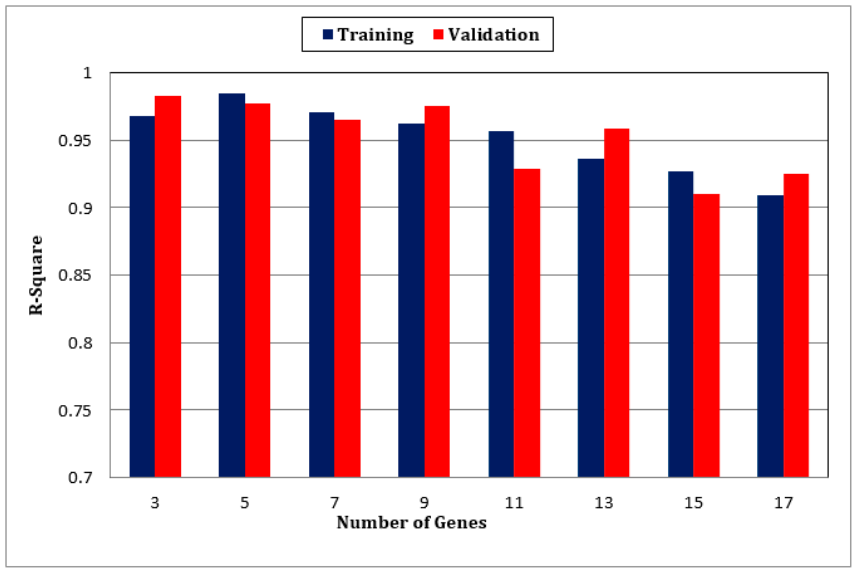
Figure 15. Comparison between R 2 of training and validation for different numbers of genes.